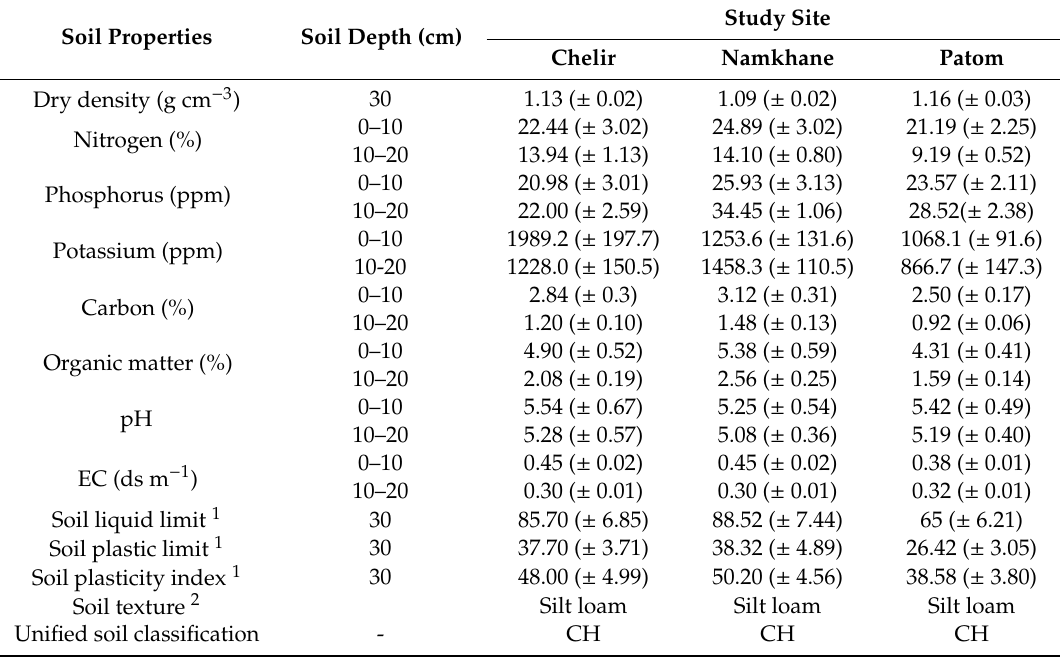
Table 1. Mean values ( ± standard error) of soil properties at the three study sites [36].